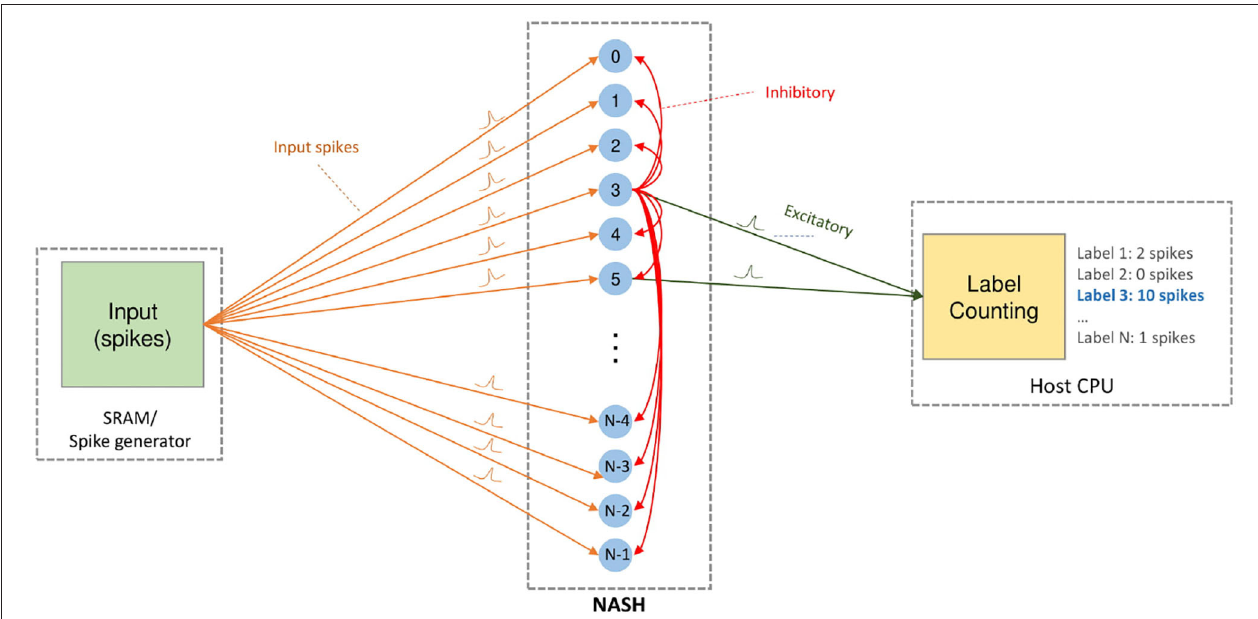
FIGURE 6 | On-chip STDP learning model.